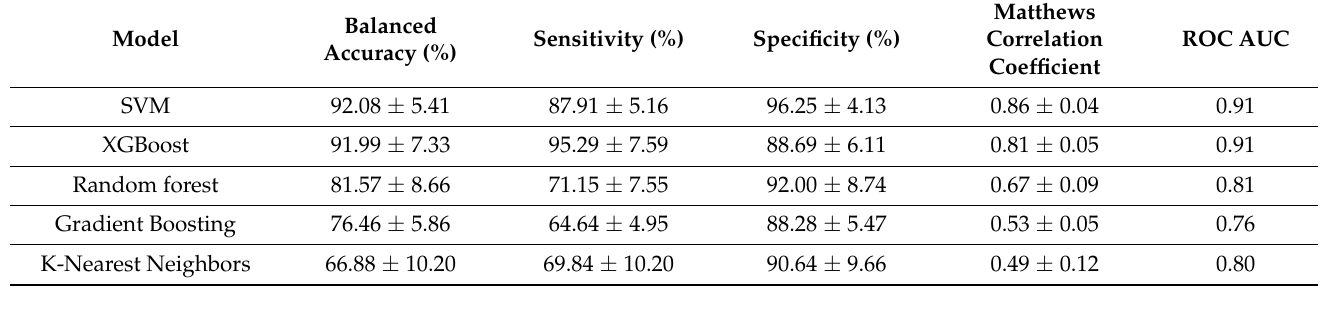
Table 3. Standard performance metrics calculated for the machine learning models.